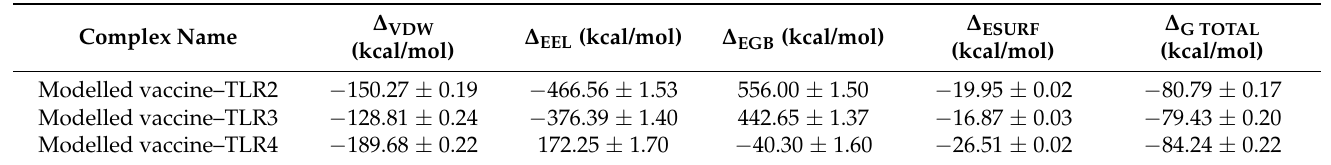
Table 5. MM/GBSA free energy calculations and individual free energy components of the con- structed vaccine–TLR2/3/4 complex. Differences